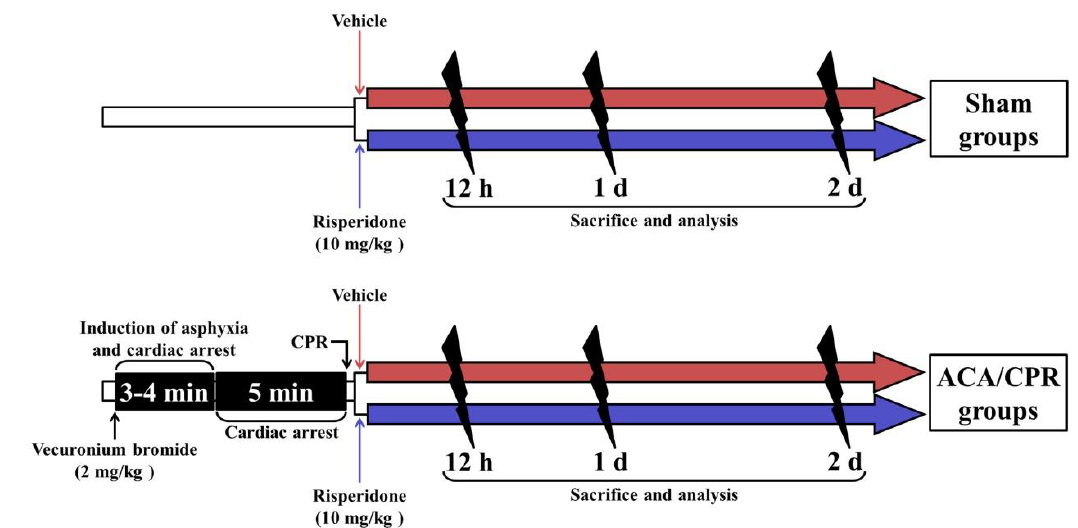
Figure 1. Experimental timeline. The rats used in this study underwent sham or ACA/CPR followed by treatment with vehicle or 10 mg/kg RIS. They were deeply anesthetized and sacrificed at 12 h, 1 day, and 2 days after ROSC, and their spinal cords were used for analyses.